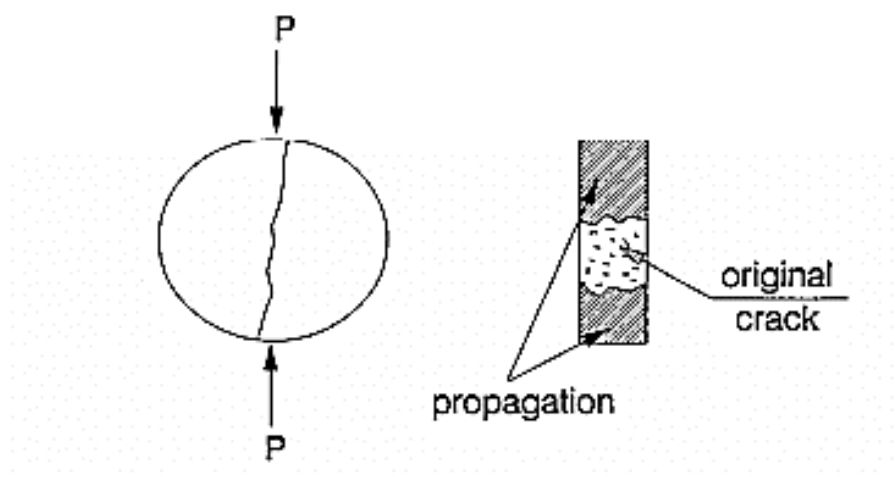
Figure 13. Scheme of the fracture in the Brazilian test.